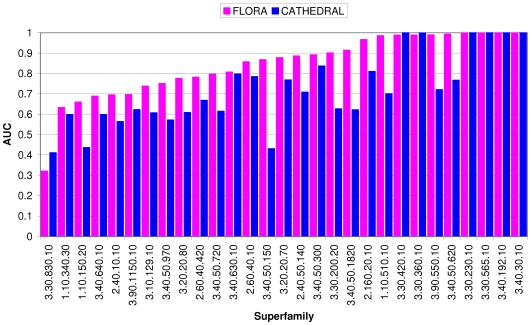
Histogram of the performance of FLORA versus CATHEDRAL for individual superfamilies, assessed using the AUC (area under ROC curve) statistic.The superfamilies were ranked according the AUC, with the worst performing listed first.